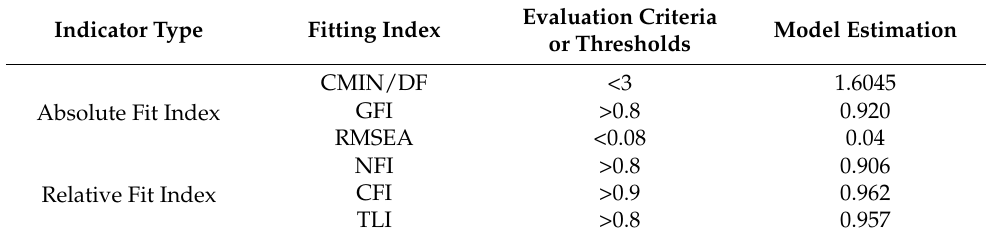
Table 7. Fitting index of the public satisfaction model.